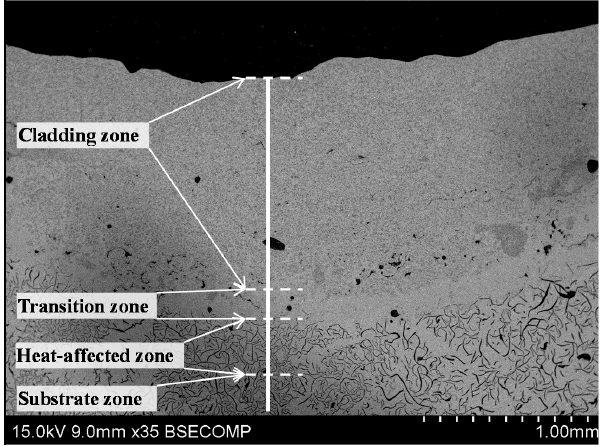
Figure 2. The BSE images of the laser cladding coating on the grey cast iron.